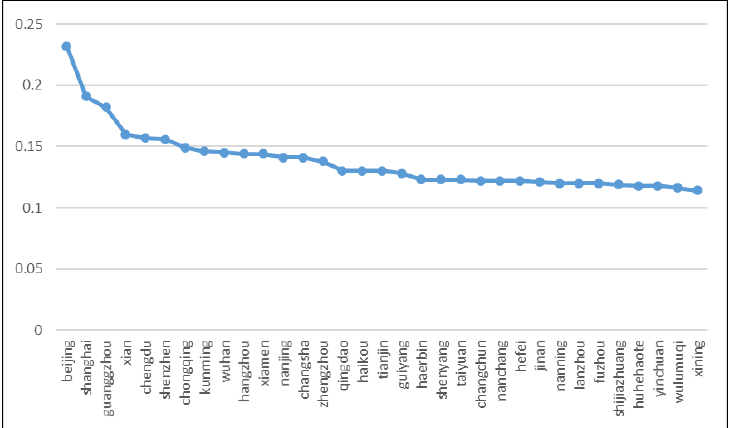
Figure 1. The direct effect of per capita GDP on passenger traffic in different regions .